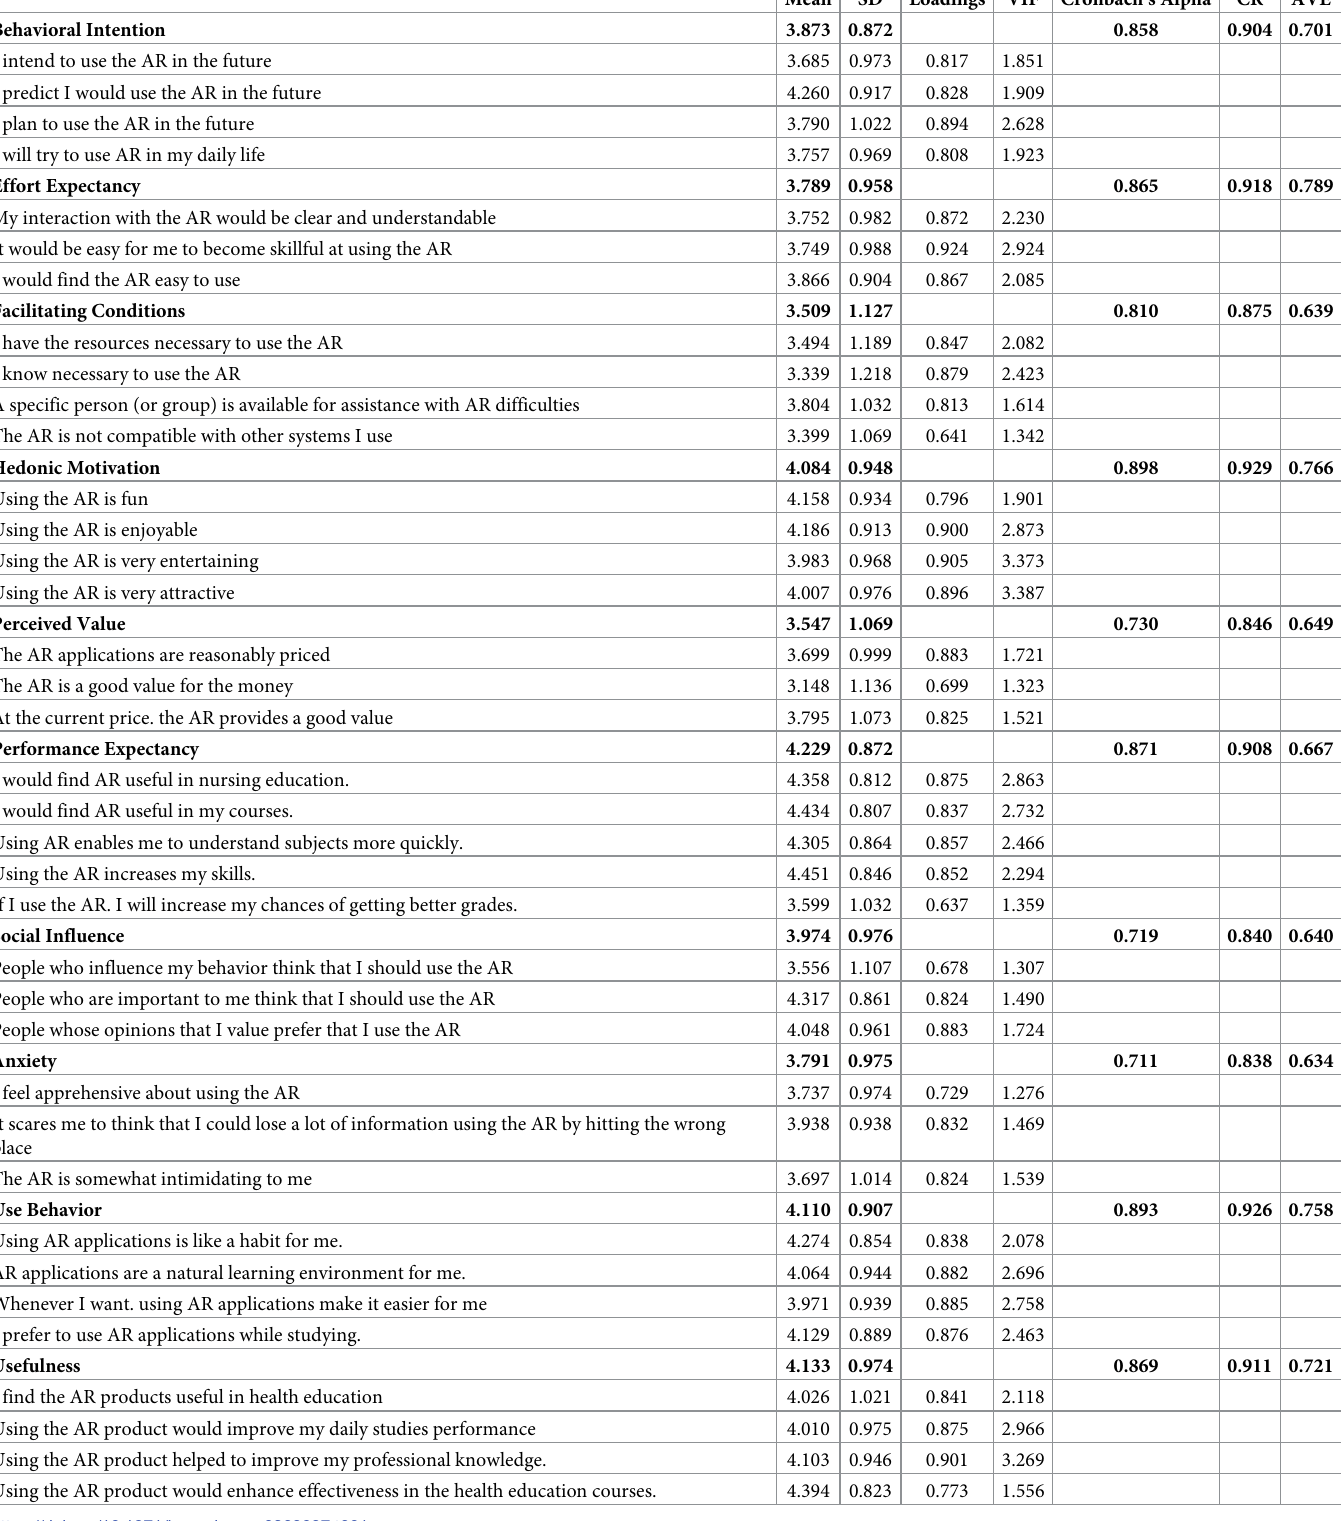
Table 1. Averages, standard deviations, composite reliability, internal consistency, multicollinearity analysis